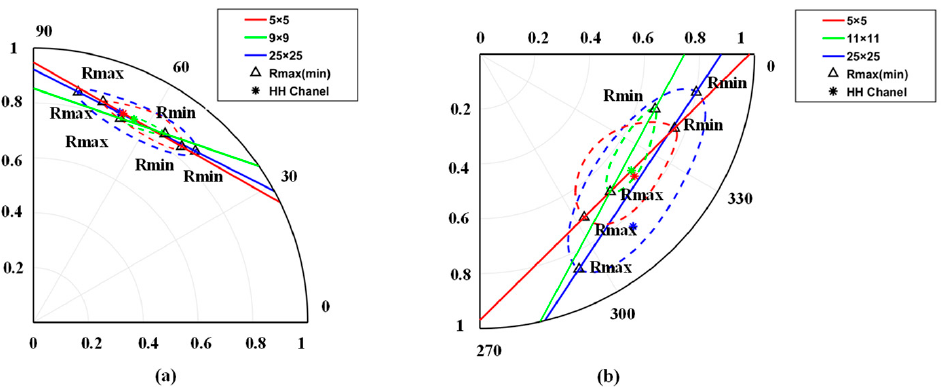
Figure 8. Geometrical interpretation including the contour of the coherence regions, the endpoints of the coherent line segment, and the corresponding lines of pixels A and D under different multilooking sizes: ( a ) pixel A for 5 × 5, 9 × 9, and 25 × 25 sizes in the Mabounie area; ( b ) pixel D for 5 × 5, 11 × 11, and 25 × 25 sizes in the Mondah area. Note that Rmax is the endpoint near the ground phase, Rmin is the endpoint away from the ground phase, and markers of different colors indicate the coherence amplitude at the HH channel under different sizes.